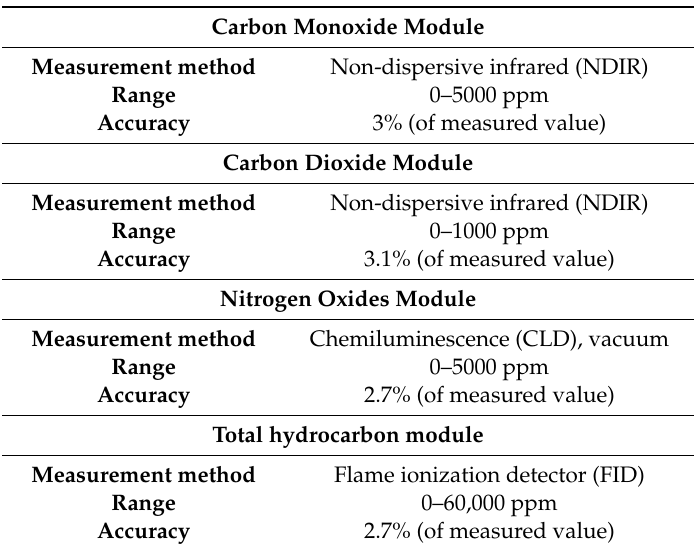
Table 1. Specifications of Horiba MEXA-ONE